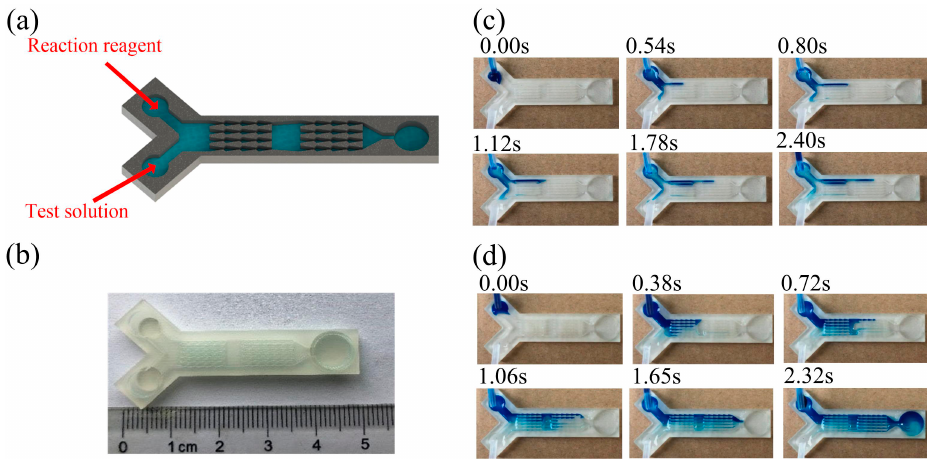
Figure 7. ( a ) Three-dimensional schematic of Y-type mixer. ( b ) The scale of the printed microstructure. ( c ) Mixing results from the Y-type mixer with a straight internal channel. ( d ) Mixing results from the Y-type mixer with an internal arrowhead